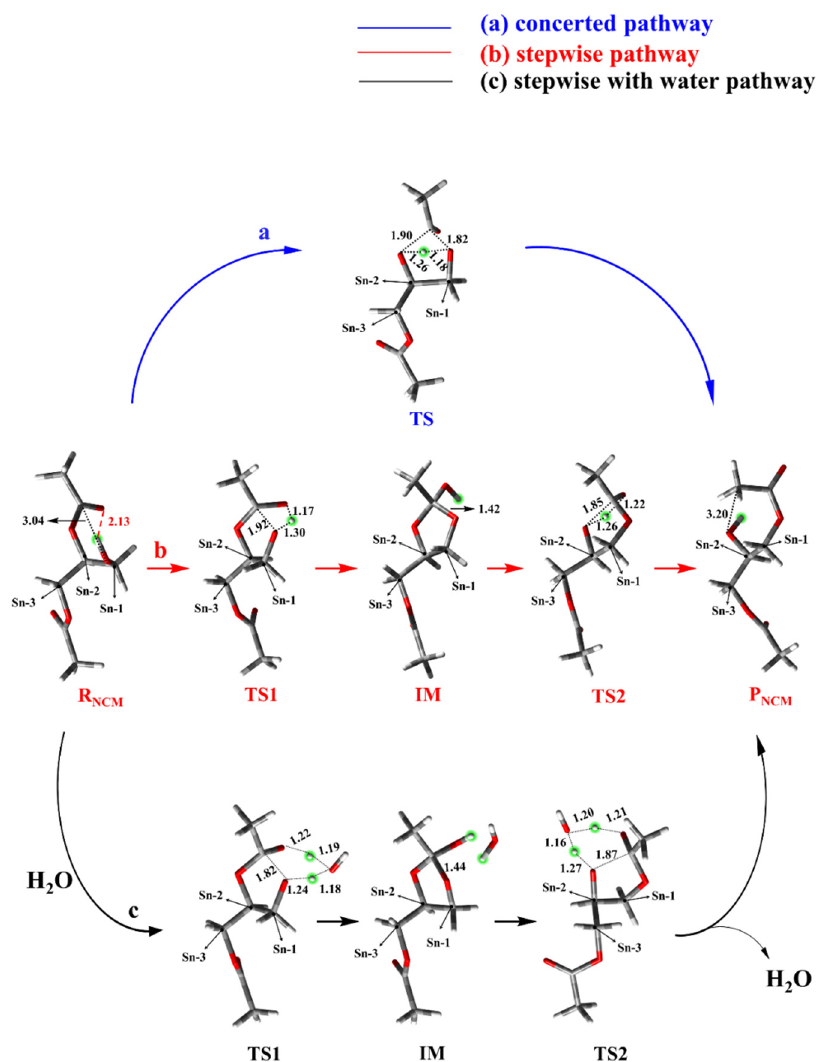
Figure 3. Optimized structures of the reactant (R NCM ), transition state (TS), intermediate (IM), and product (P NCM ) of NCM for the concerted pathway ( a ), stepwise pathway ( b ), and stepwise pathway with the aid of water ( c ).